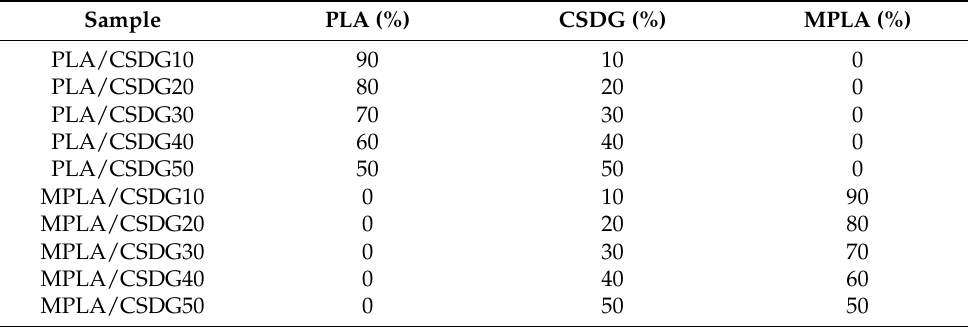
Table 1. Composition of PLA/CSDG and MPLA/CSDG